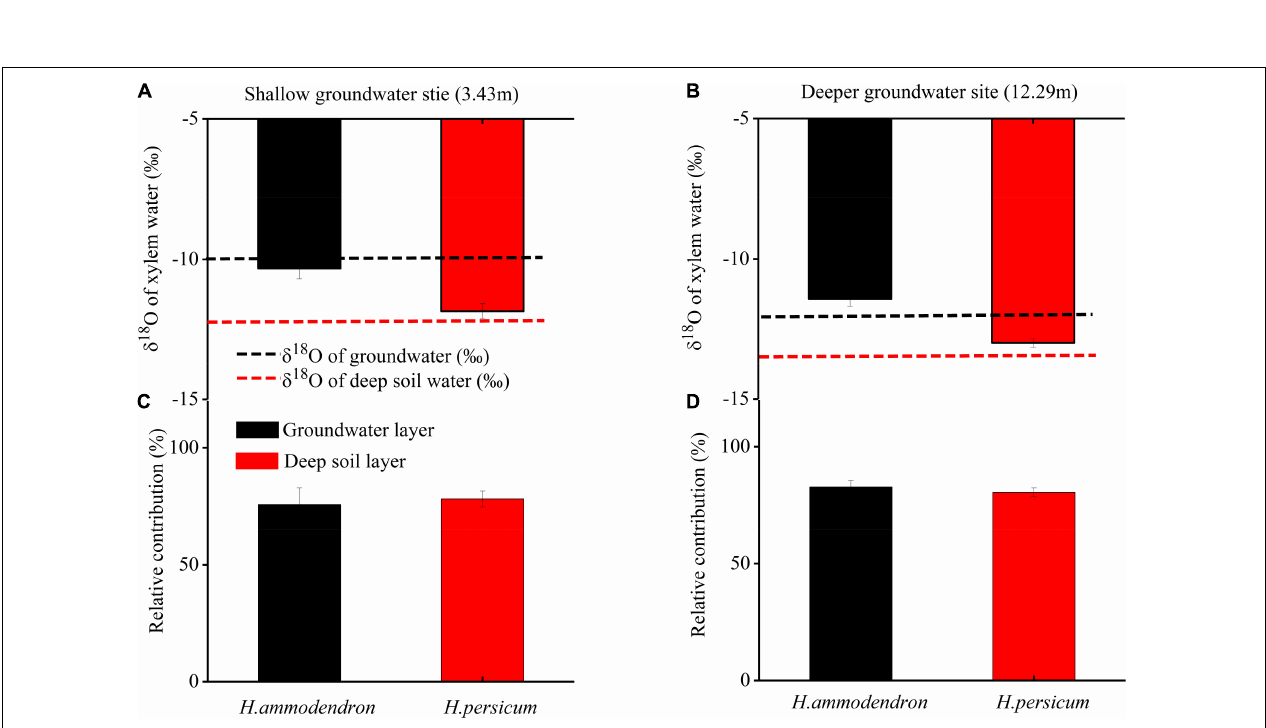
FIGURE 3 | Comparison of the oxygen stable isotope ratio ( δ 18 O) of xylem water and deep soil water and groundwater (A,B) , and the relative contribution of different water sources (C,D) for the two Haloxylon species at two sites.